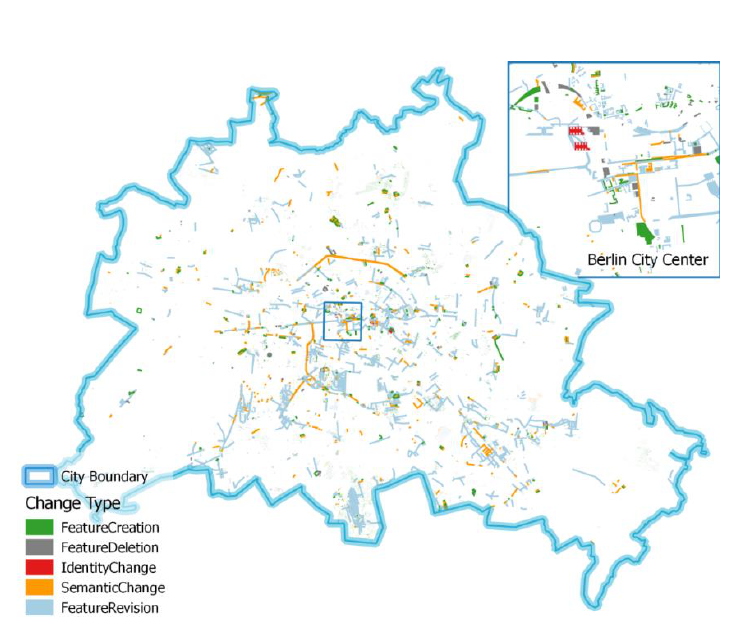
Figure 11. Change map of Kathmandu showing classified changes between January and June 2015.